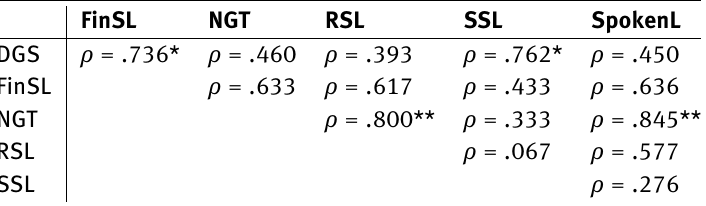
Table A2: The statistical rank correlation across ValPaL verb meanings within each language dyad for our five sign languages and the combined spoken languages from Haspelmath (2015). Locative verb meanings are removed for all